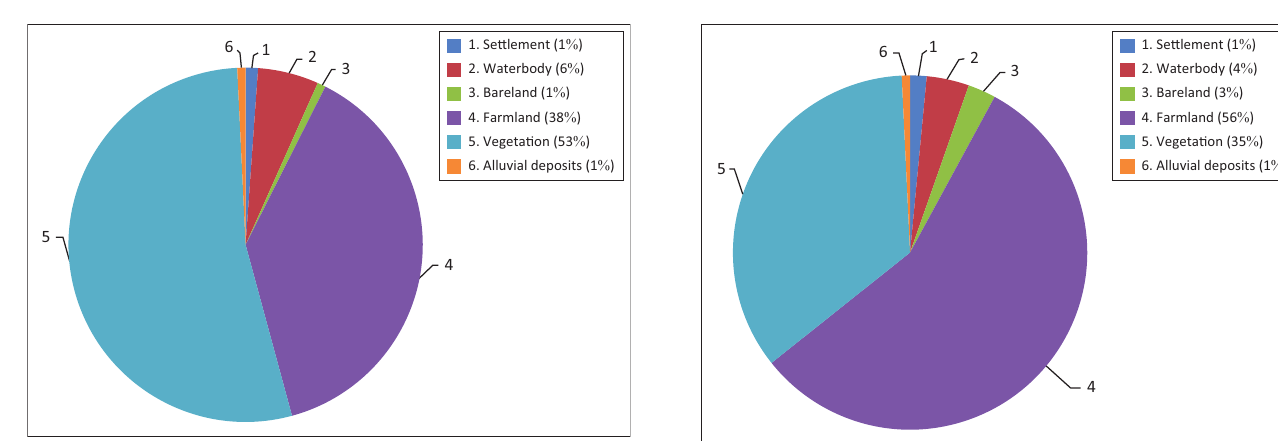
FIGURE 7: 2014 flooded Local Government Area in Adamawa State map.